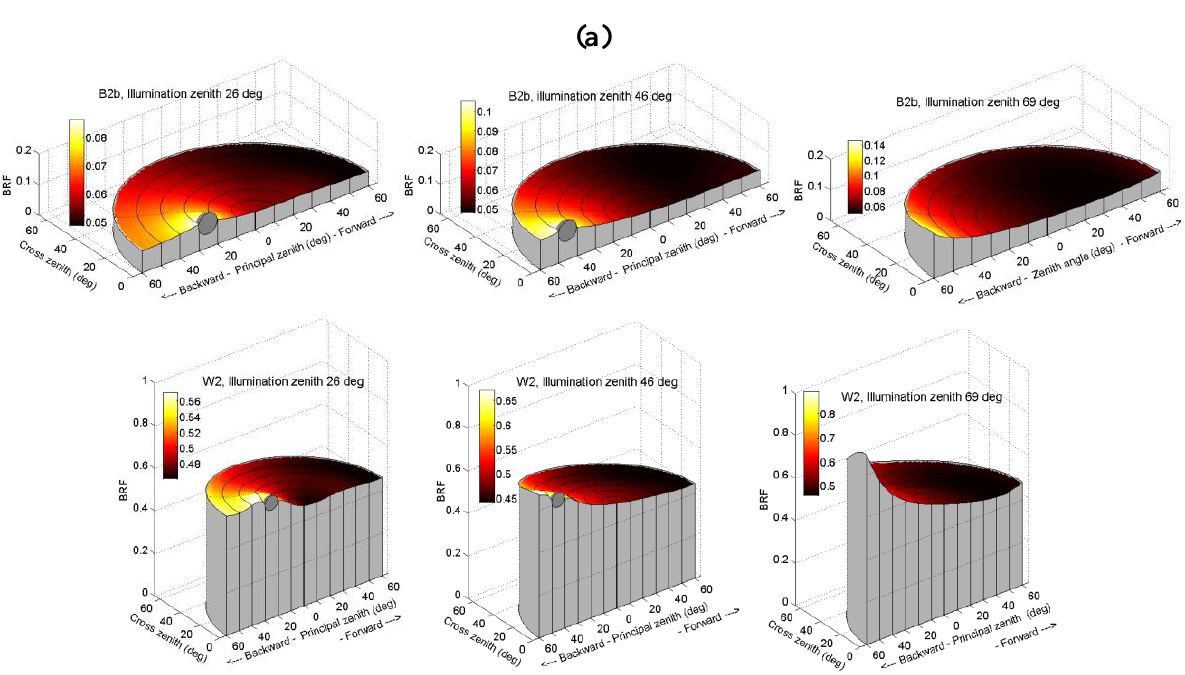
Figure 8. Influence of illumination height (zenith angles 26° 46° and 69°) on reflectance factors. (a) 3-D BRF plots of black (B2b) (top) and white (W2) (bottom) gravels on green channel (550 ± 25 nm). (b) Relative differences of measurements with 26° and 46° (left) and 46° and 69° (right) illumination zenith angles on the PAN channel at the principal plane (Equation 7; the measurement with smaller illumination zenith angle was used as a